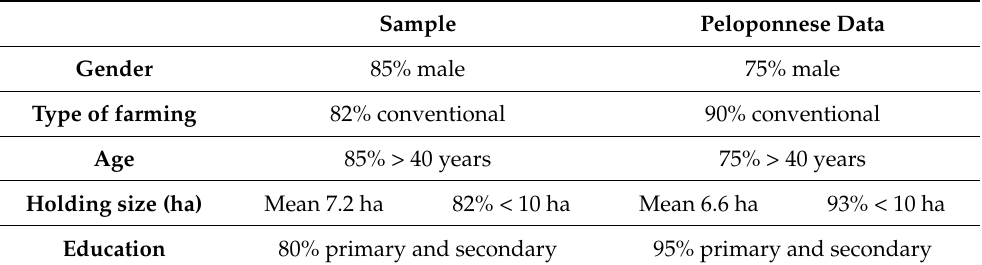
Table 1. Sample data adapted from FADN and Peloponnese data [36].